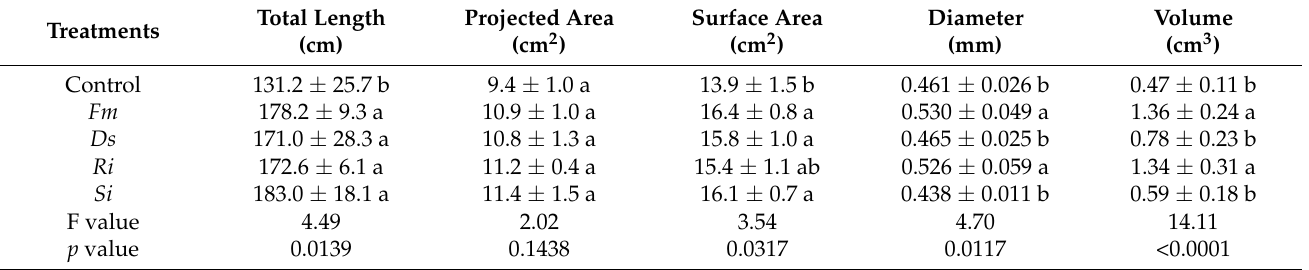
Table 2. Effect of inoculation with different symbiotic fungi on root system architecture of Vicia villosa .